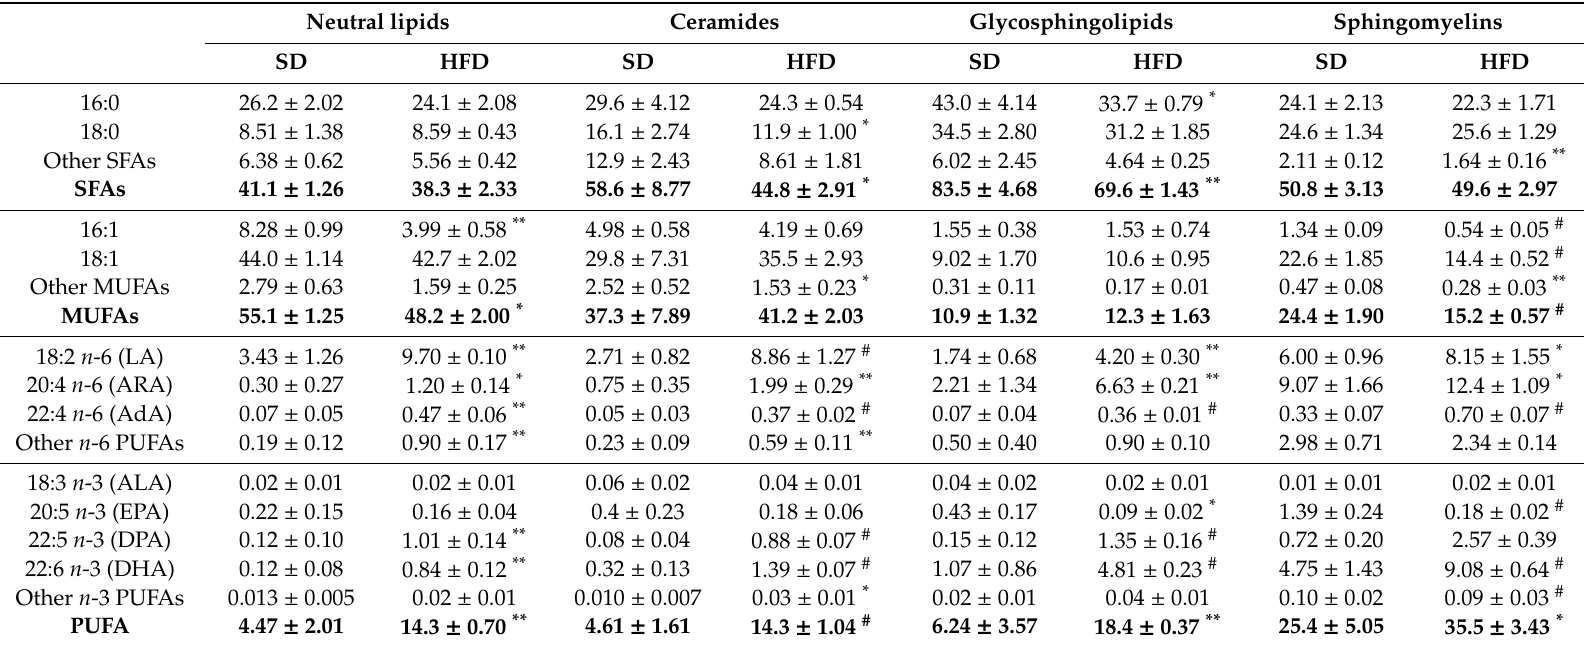
Table 4. Fatty acid content (%) in heart fractions obtained with the Bodennec et al. [63] method. Neutral lipids Ceramides